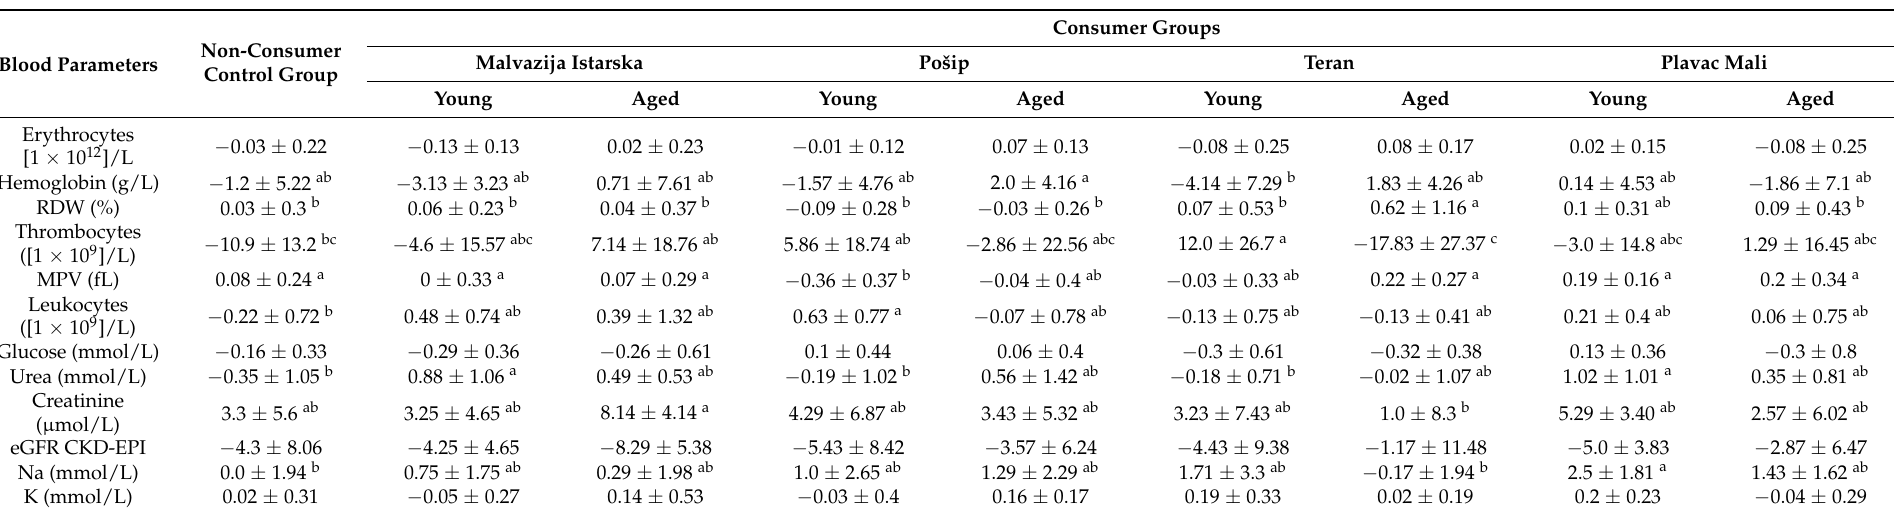
Table 10. Changes in different blood parameters between the first and the second measurement in eight consumer groups and one non-consumer group of study